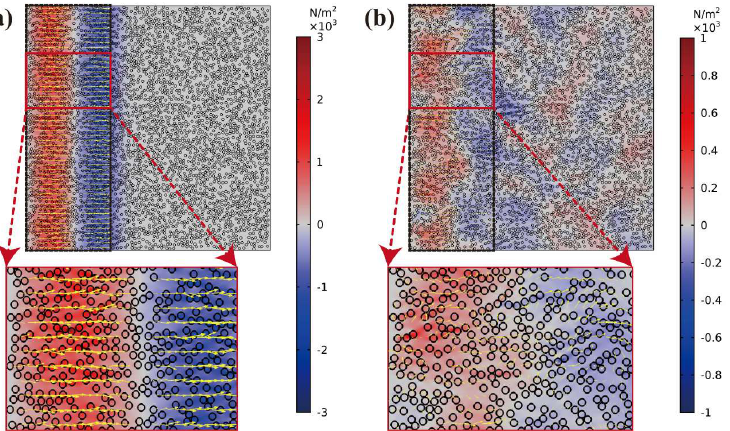
Figure 8. Stress distribution of elastic wave propagating behavior in Cu/PMMA composites: ( a ) At 0.4 µs; ( b ) At 1.2 µs.